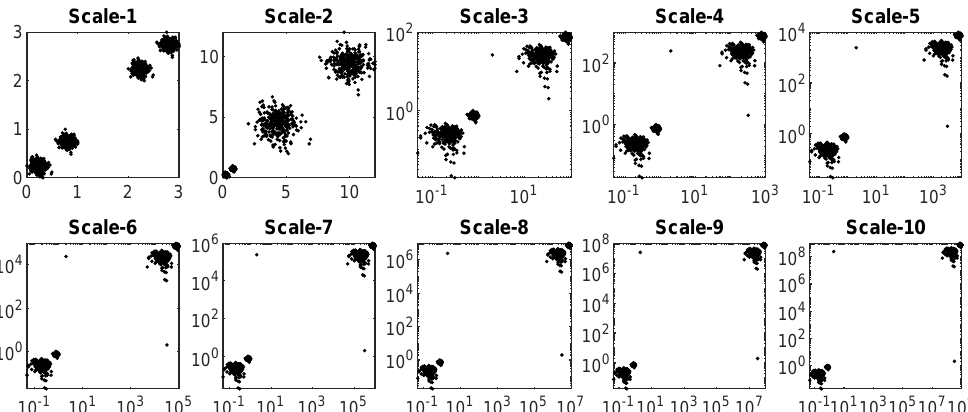
Figure 10. Ten datasets with different scales of clusters visualized. Except datasets Scale-1 and Scale-2, all the other datasets are visualized in logarithmic scale (in the linear scale, some clusters could not be visually found).